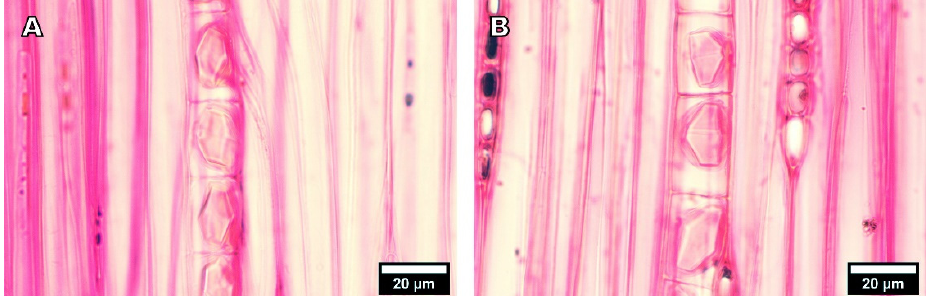
Figure 6. Optical micrographs prismatic crystal in chambered axial parenchyma cells of Acacia mangium ( A ) and A. hybrid ( B ). Table 2. Qualitative anatomical characteristics of both Acacia mangium and Acacia hybrid based on the International Association of Wood Anatomists (IAWA) feature